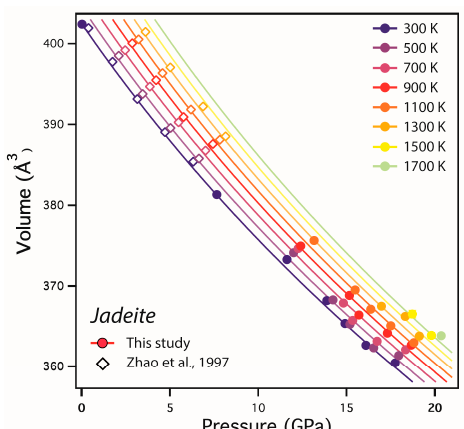
Figure 6. Unit-cell volume of jadeite as a function of pressure and temperature. Plain circles represent our volume data while open diamonds are data taken from Zhao et al. [22]. The color-scale represents the data at temperatures varying from 300 K to 1700 K, respectively. Pressure and volume error bars are within the size of the symbols. Solid lines represent the isothermal compression curves obtained from fitting all data to a Birch–Murnaghan EoS (Equations (1)–(5)).